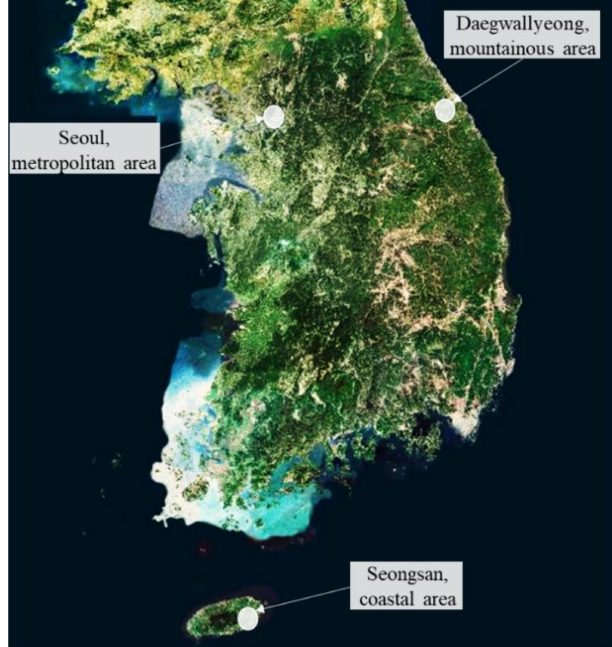
Figure 3. Selected regions in South Korea. Map is from Korea National Geographic Information Institute